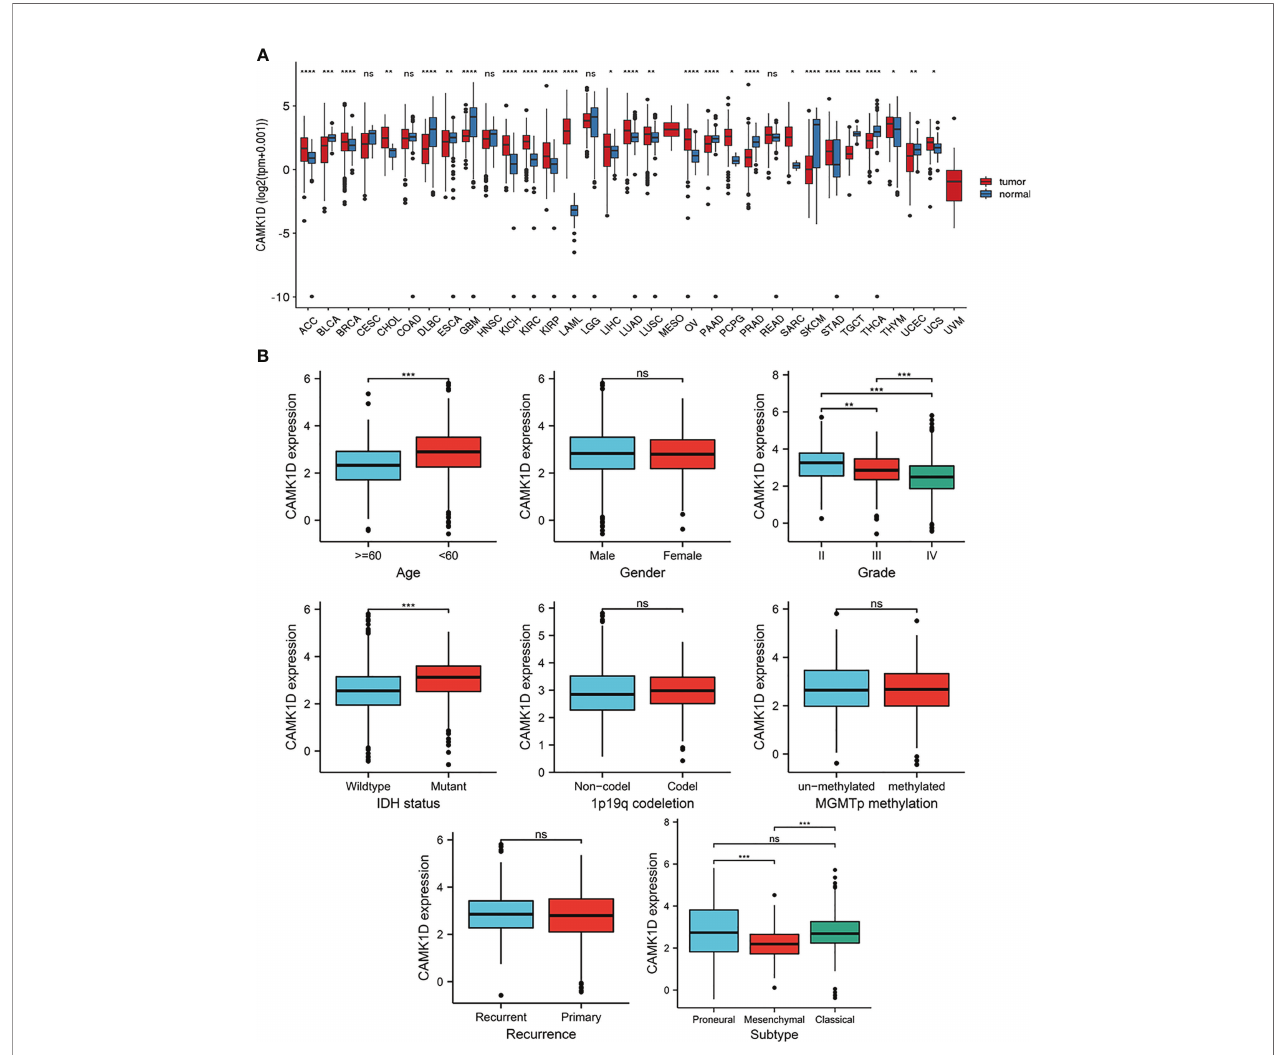
FIGURE 1 | Pan-cancer analysis of CAMK1D expression and the relationship between the expression of CAMK1D and clinicopathological features. (A) CAMK1D mRNA expression in pan-cancer dataset of TCGA. (B) Expression of CAMK1D in different age, genders, WHO grades, IDH status, 1p19q codeletion, recurrence, MGMTp methylation, and subtypes of glioma. Please note the CAMK1D gene expression level changes in different tumor tissues. Furthermore, CAMK1D expression level was low in glioma tissue with higher WHO grade patients. ns, no signi fi cance; *p < 0.05 < ** p < 0.01 < *** p < 0.001 < **** p <